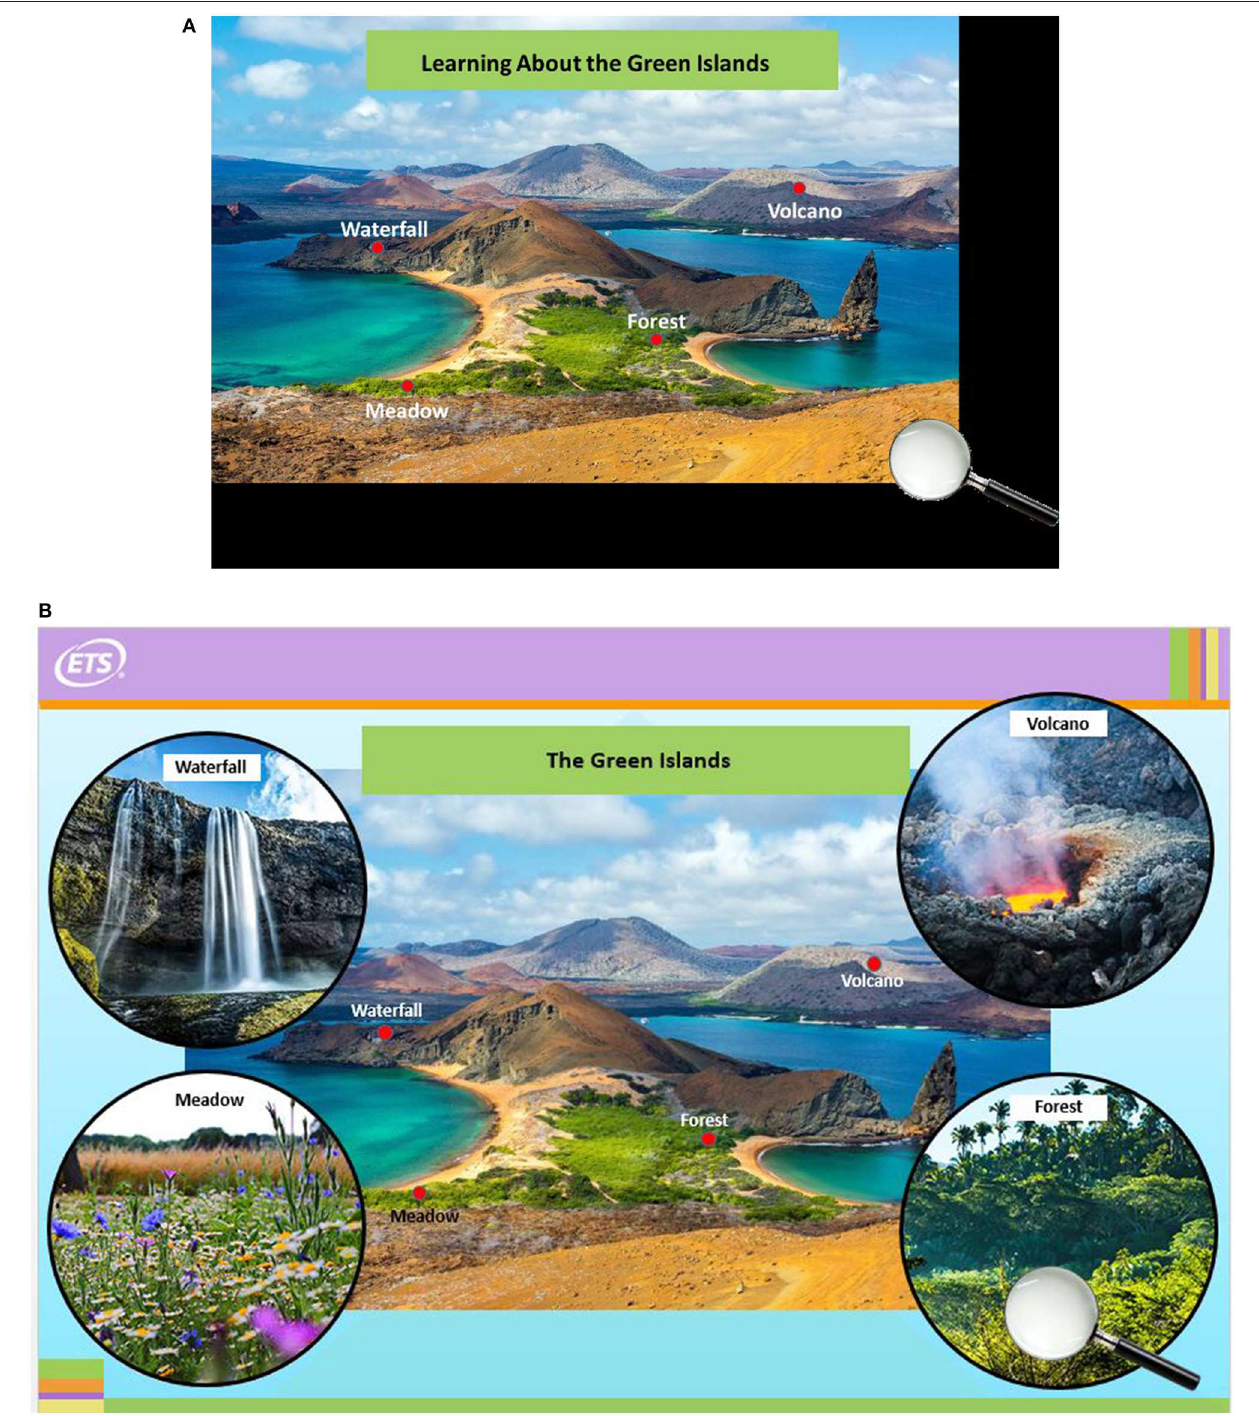
FIGURE 2 | (A) Example of a pop-up illustration glossary. © Michaël Lejeune, CC-BY-SA-3.0, Wikimedia Commons. (B) Example of a pop-up illustration glossary. © Michaël Lejeune, CC-BY-SA-3.0, Wikimedia Commons.